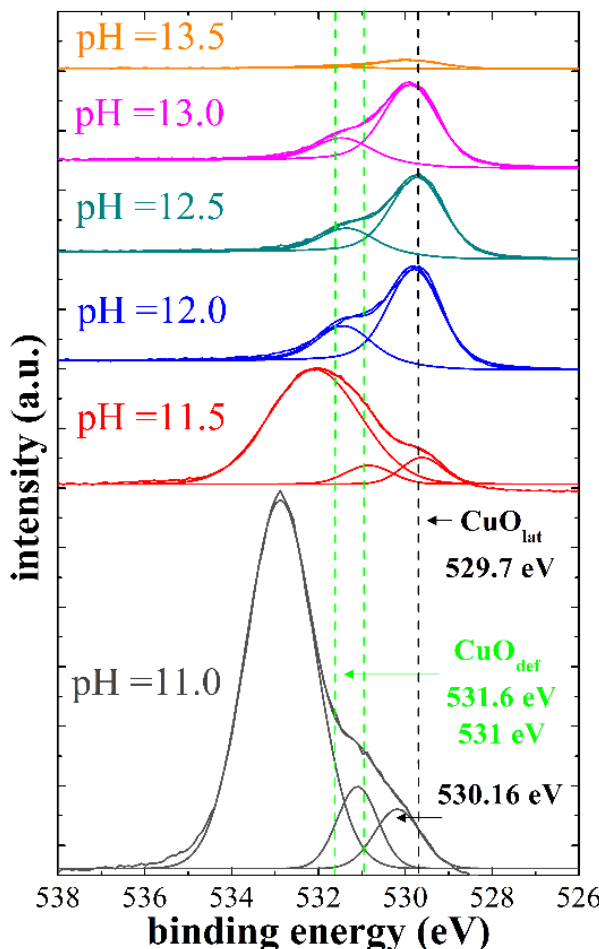
Figure 5. Deconvoluted peaks of the high-resolution XPS spectra of the O1s core level of the CuO films obtained at different pH values.